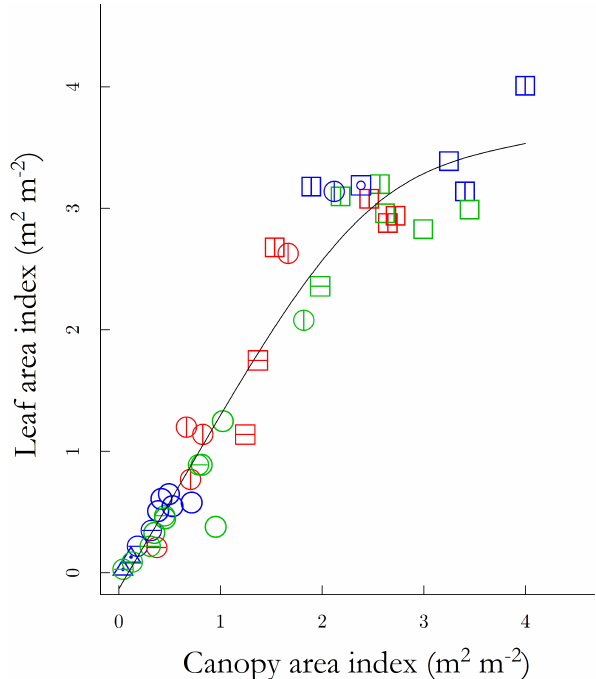
Figure 1. Relationship between woody plant canopy area index ( C W ) and leaf area index ( L ) symbols, ( ◬ ) grassland and grass- land savanna, ( ⊖ ) shrub-rich savanna formation types, ( ○ ) savanna and woodland formation types, ( ⦶ ) tall woodlands, ( ⊟ ) stunted forests, ( □ ) forest, ( ◫ ) tall forest. Vegetation nomenclature follows Torello-Raventos et al. (2013). Blue symbols, Africa; Green sym- bols, South America; Red symbols, Australia. The fitted line repre- sents a quadratically penalised generalised general linear model fit with the variance modelled as an exponential function of C W